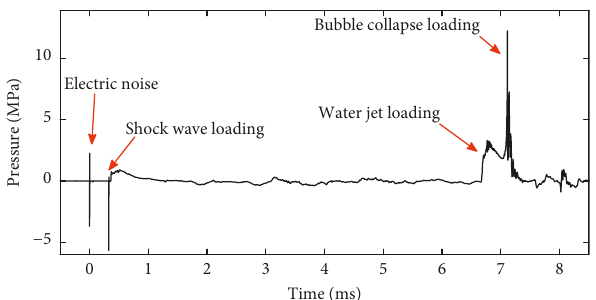
4.1945ms. (e) t (cid:30)